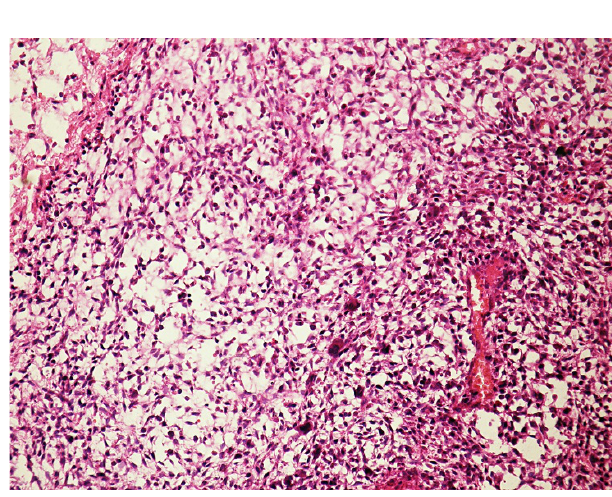
Spindled mononuclear cells and dispersed osteo- clasts in Case 1. (H&E, × 200)